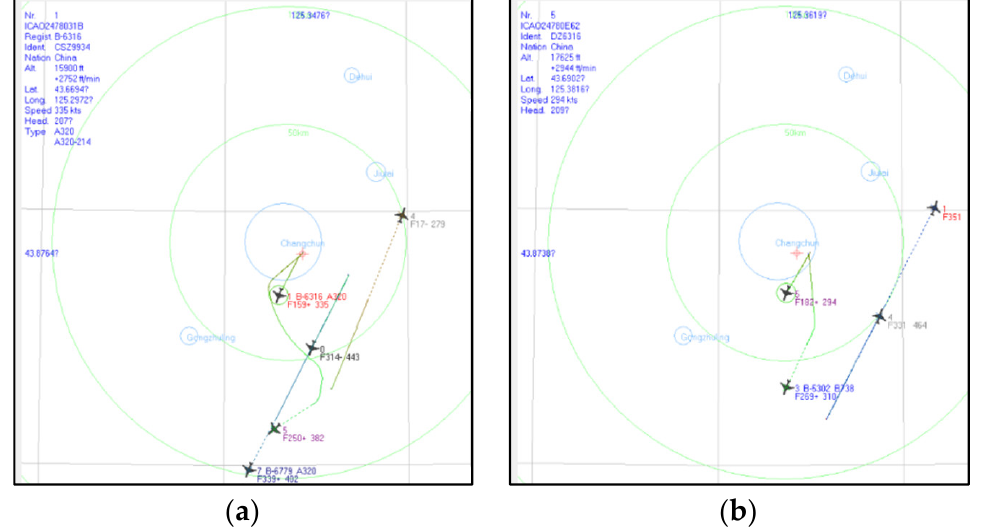
Figure 16. ADSB receiver data shown on ADSB Scope Software: ( a ) Target 1 Airline 0 from Korea was detected; ( b ) Target 2 Airline 4 from China was detected.